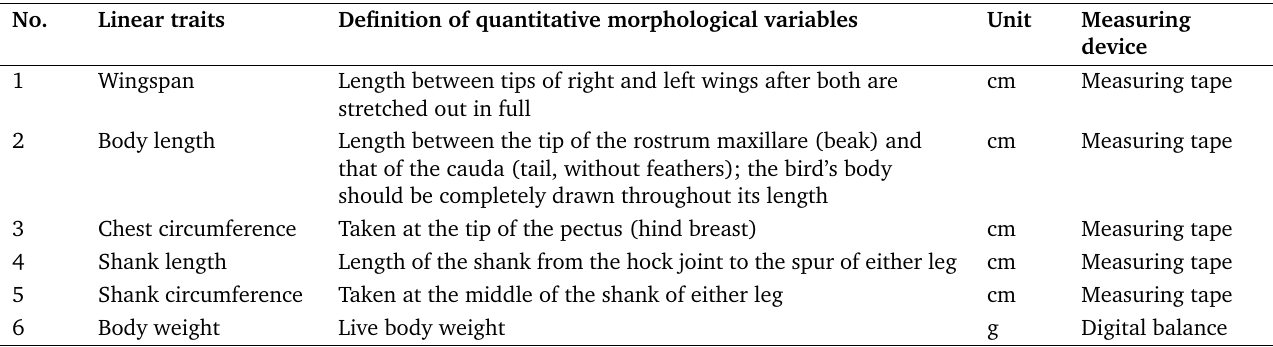
Table 2. Six quantitative measurements definition and description of measuring devices used to characterize chicken populations. Adapted from FAO